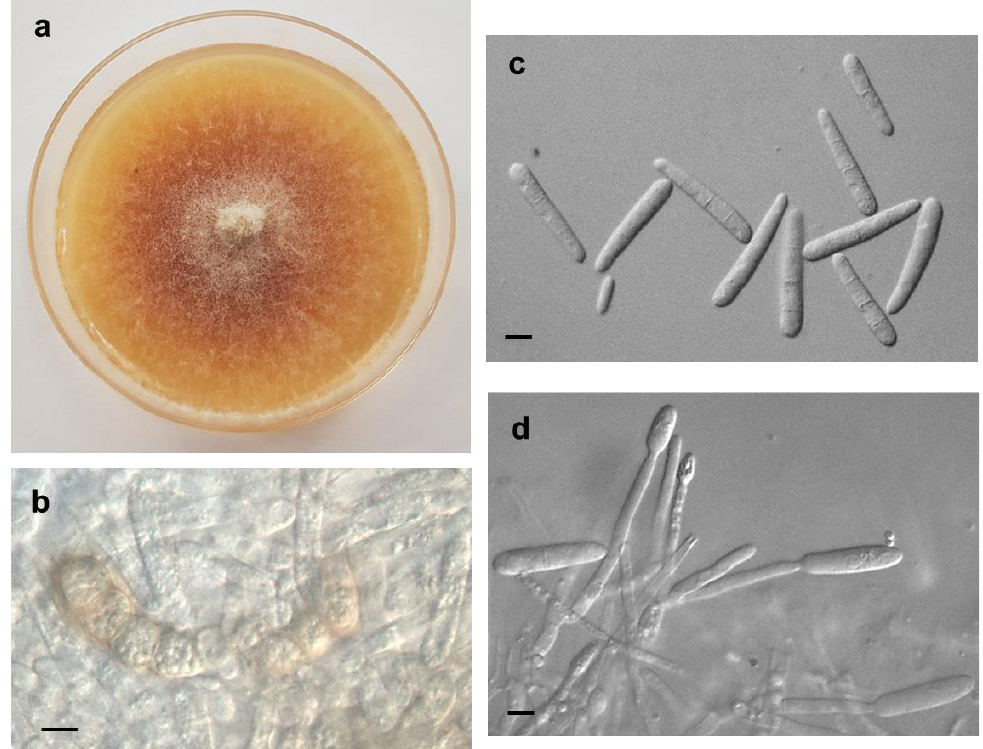
Figure 3. Morphology of Dactylonectria macrodidyma (asexual form Cylindrocarpon macrodidymum ) isolate DAFE SP16-21: ( a ) Colony on PDA. ( b ) Chlamydospores. ( c ) Micro- and macroconidia formed on PDA. ( d ) Simple, unbranched septate conidiophores on PDA. Scale bars = 10 µm. Amplicons of 569 and 544 bp (ITS), 347 bp ( TUB2 ) and 499 bp ( HIS3 ) were obtained for the fungal isolates DAFE SP16-21 and DAFE SP16-22, respectively. BLASTn search using ITS and TUB2 sequences were ineffective in distinguishing D.